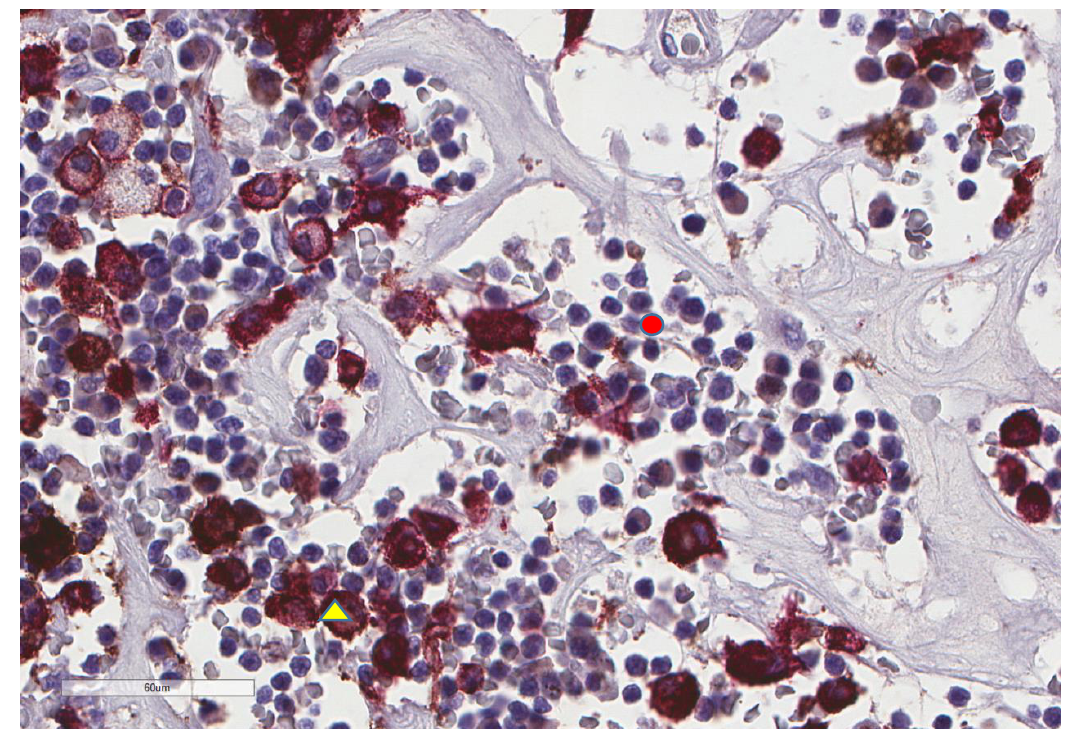
Figure 11. Representative microscopic image of a double stain for PD-L1 (DAB = brown) and CD8 (magenta), showing that most CD8 cells (yellow triangle) do not express PD-L1, which is found in larger cells (red circle) (×400 magnification).